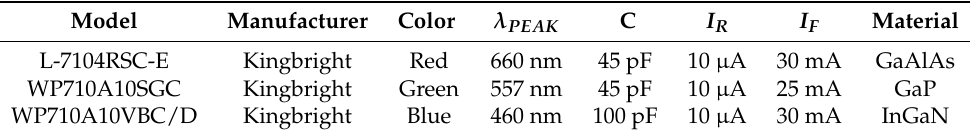
Figure 5. Wavelength of monochromatic LEDs used for the test, each one normalized to its wavelength radiation peak, obtained from the LEDs data-sheet. Table 1. Characteristics of the monochromatic LEDs used for the